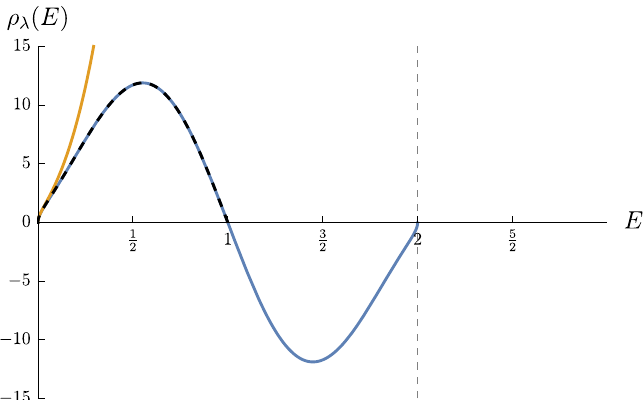
(cid:112) E ) of JT